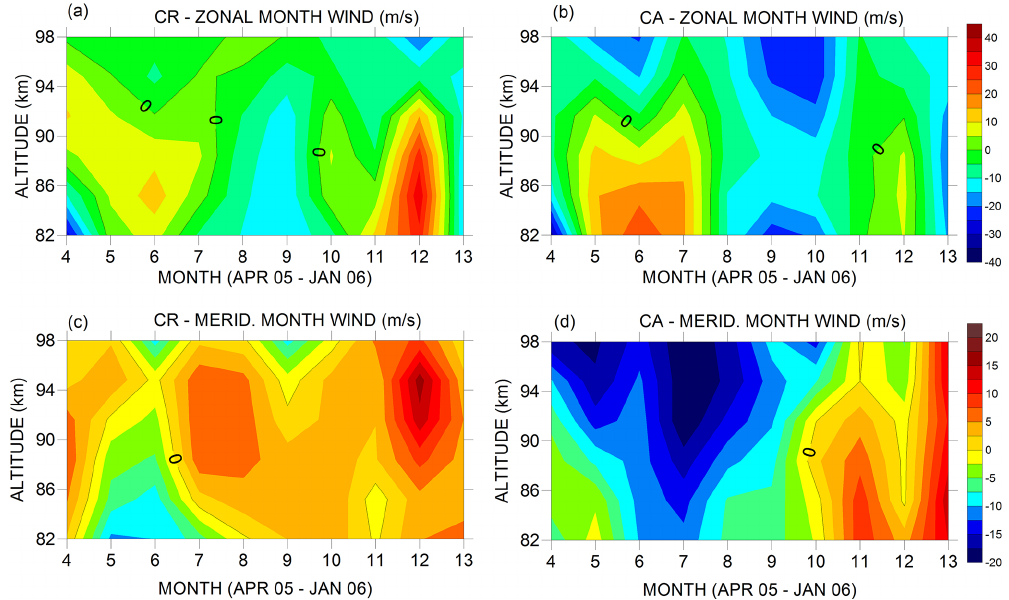
Figure 1. Monthly averages of zonal (top) and meridional winds in CR (a, c) and CA (b, d) from April 2005 to January 2006. The color scales used for the zonal and meridional winds in the graphs are different.